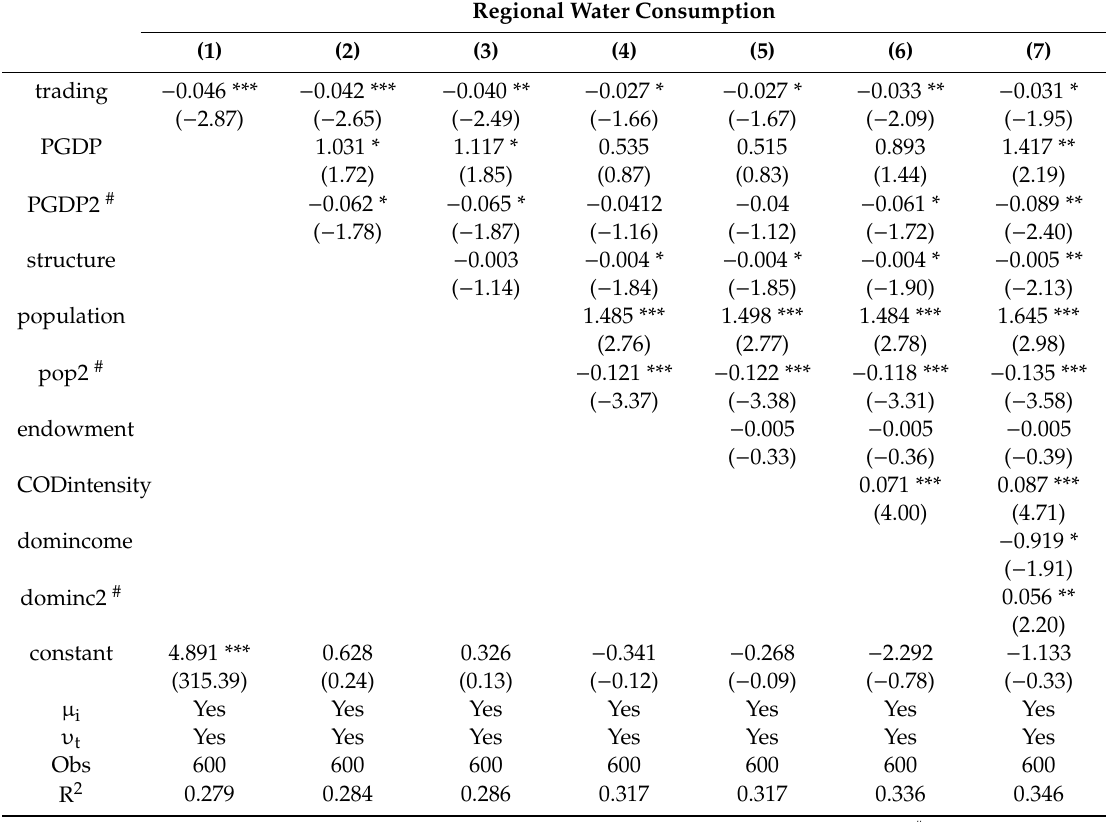
Table 2. The estimation results in the time-varying di ff erence-in-di ff erences (DID) model.